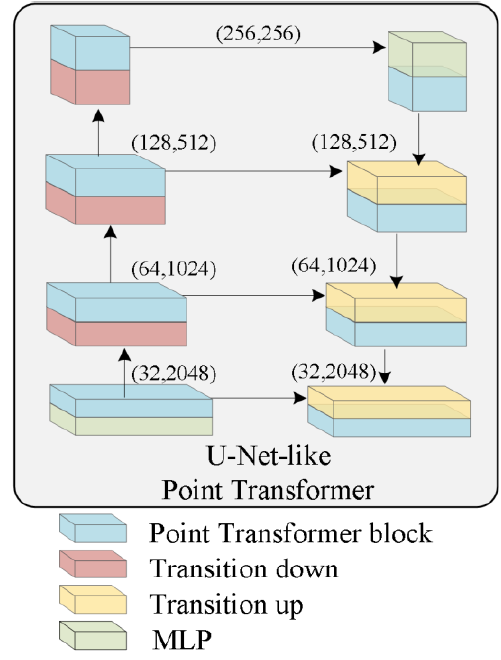
Figure 2. The network architecture of the general semantic segmentation block.